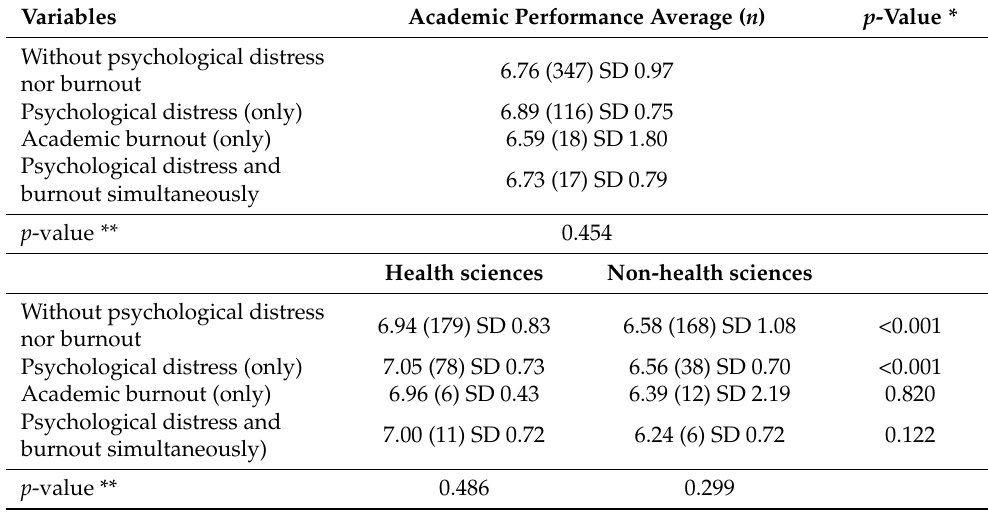
Table 5. Psychological distress, burnout, and academic performance ( n = 498). Values are expressed as mean marks with numbers of students in